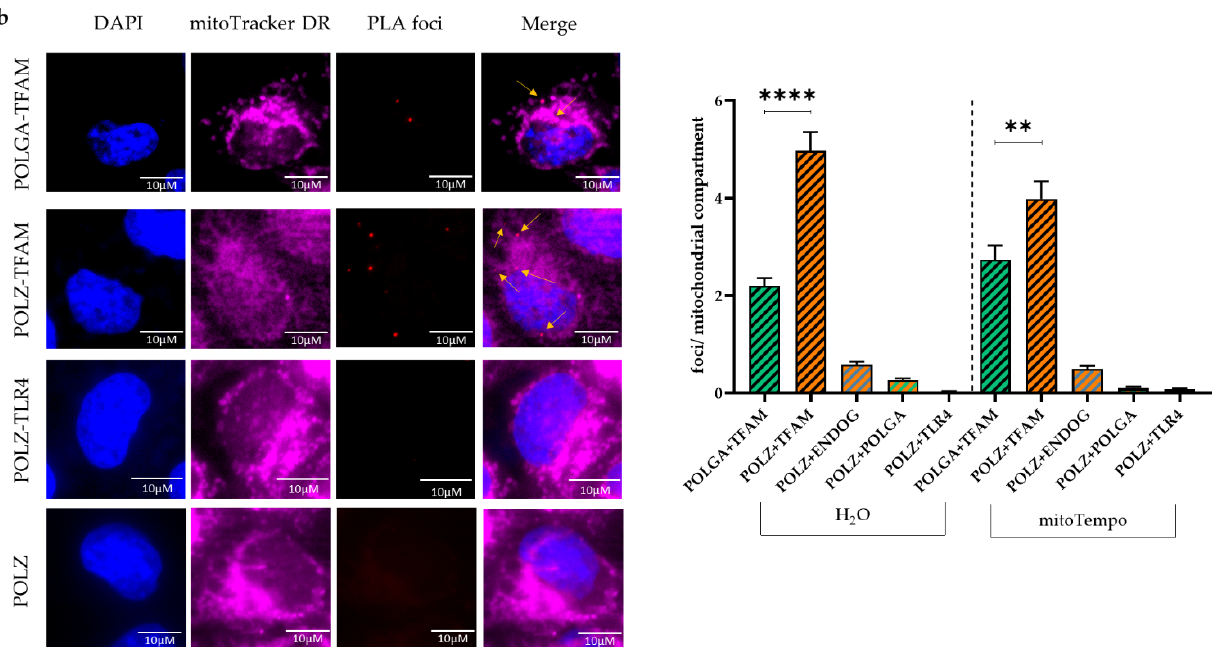
Figure 7. POLZ localizes to mitochondria. Representative images of POLZ fluorescence intensity in HeLa cells treated for 48 h with DMSO or 10 µM mitoBlock-6 ( left ) and their quantification ( right ) of two independent experiments, n = 92–99 cells ( a ). Representative images of the proximity ligation assay (PLA, left ) and the quantification of PLA foci ( right ) of two independent experiments, n = 100–183 cells ( b ). All values are means ± SEM (* p ≤ 0.05, ** p ≤ 0.01, **** p ≤ 0.0001), scale bar = 10 µM.